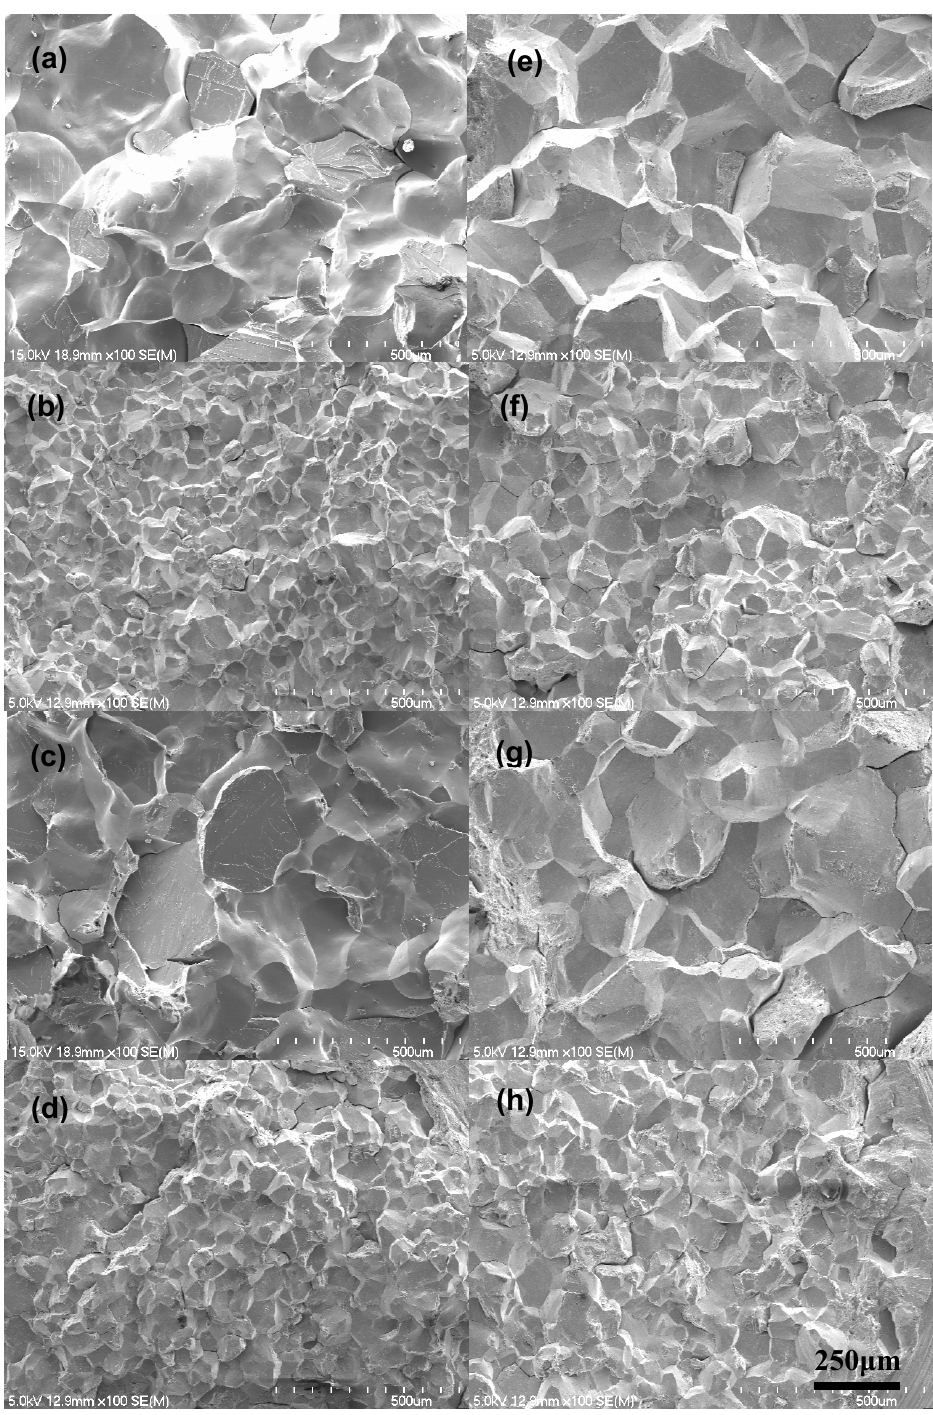
Figure 2. Scanning electron fractographs of the AES (Auger electron spectroscopy) specimens with the largest and smallest grain sizes for both IF and 2.25Cr-1Mo steel (IF steel: ( a ) aged at 600 °C/largest grain size; ( b ) aged at 600 °C/smallest grain size; ( c ) aged at 680 °C/largest grain size; and ( d ) aged at 680 °C/smallest grain size; and 2.25Cr-1Mo steel: ( e ) aged at 520 °C/largest grain size; ( f ) aged at 520 °C/smallest grain size; ( g ) aged at 560 °C/largest grain size; and ( h ) aged at 560 °C/smallest grain size).